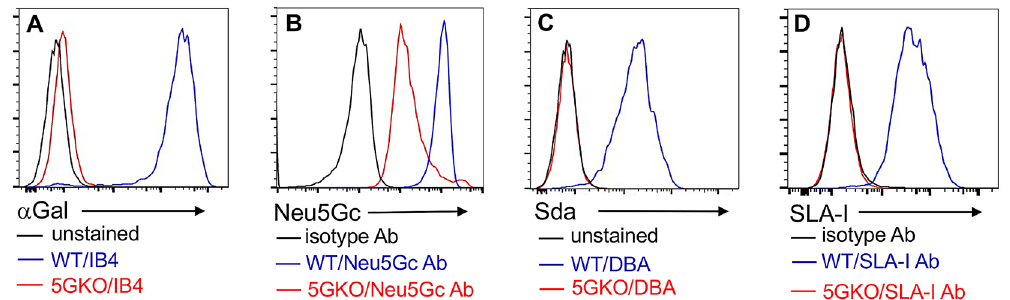
Figure 2. Phenotype of GM ipLDEC. Flow cytometric analysis of the absence of αGal ( A ), Sda ( C ), and SLA-I ( D ), and reduction of Neu5Gc ( B ) on ipLDEC (due to uptake of Neu5Gc glycan from Neu5Gc-rich FBS in culture medium).